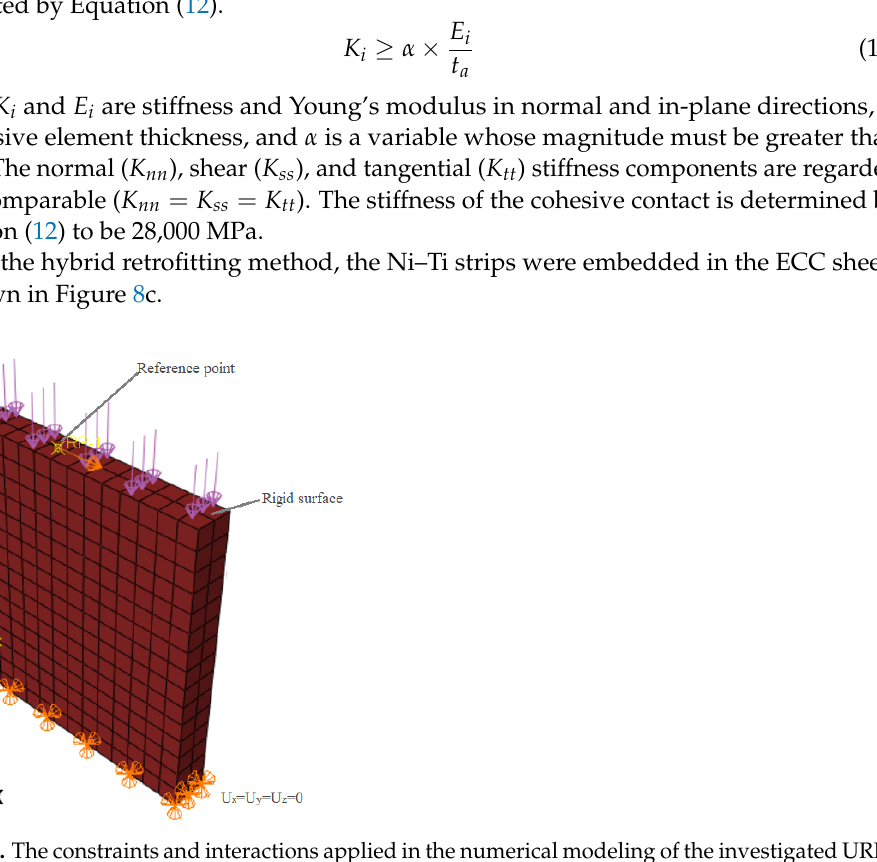
Figure 7. The constraints and interactions applied in the numerical modeling of the investigated URM.